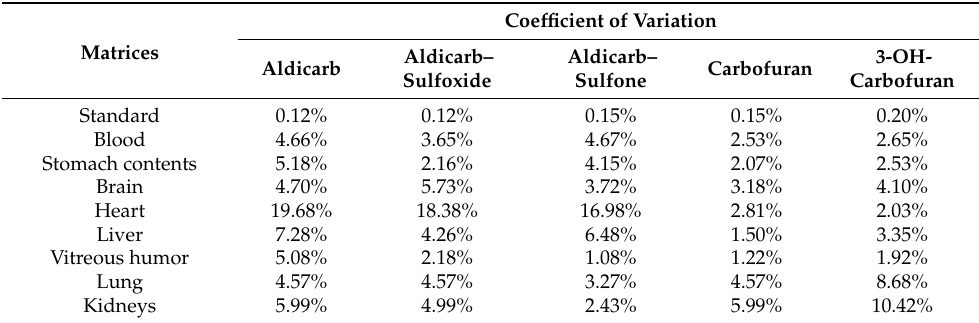
Table 3. Variant coefficient of the calibration curves for aldicarb, aldicarb–sulfoxide, aldicarb–sulfone, carbofuran, and 3-OH-carbofuran for the analyzed matrices.